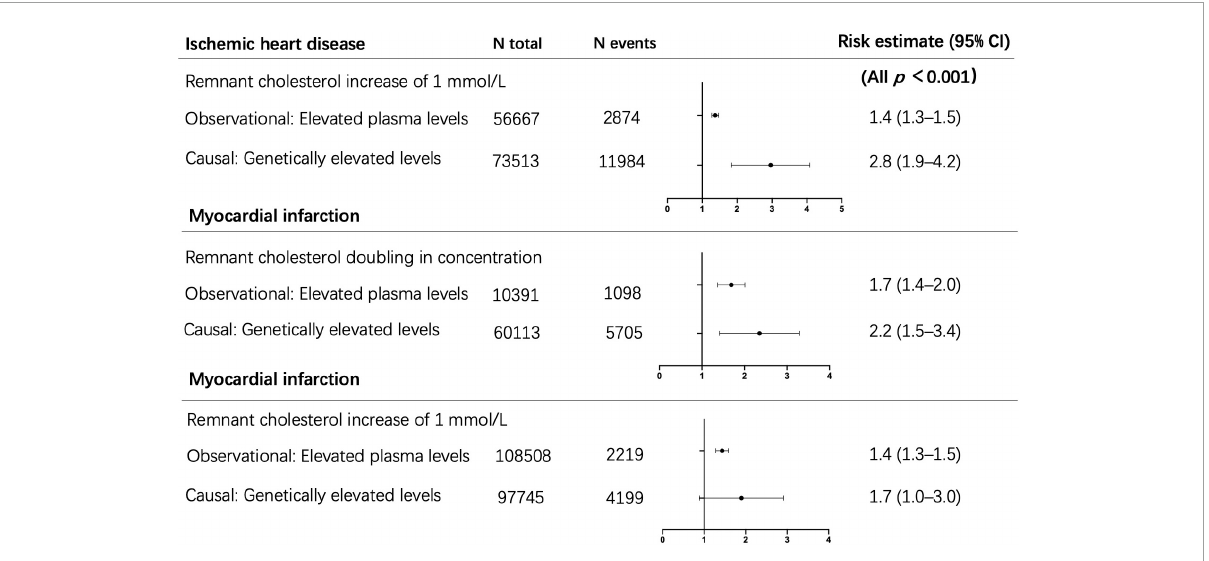
FIGURE4 Observational and causal (by use of genetics) associations of elevated remnant cholesterol with risk of ischemic heart disease and myocardial infarction. Top section adapted from Varbo et al. (10). Middle section adapted from Jørgensen et al. (58). Bottom section adapted from Nordestgaard et al. (59). N,